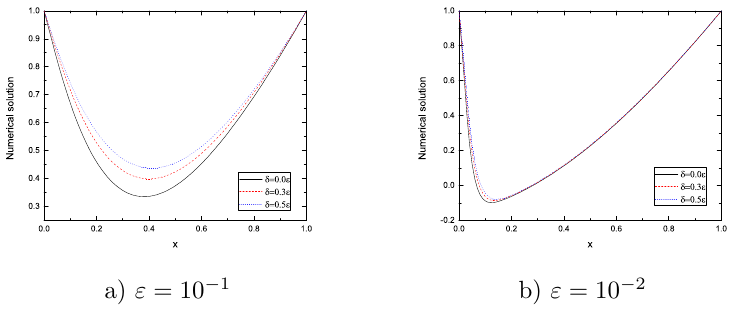
Figure 1. Numerical solution for Example